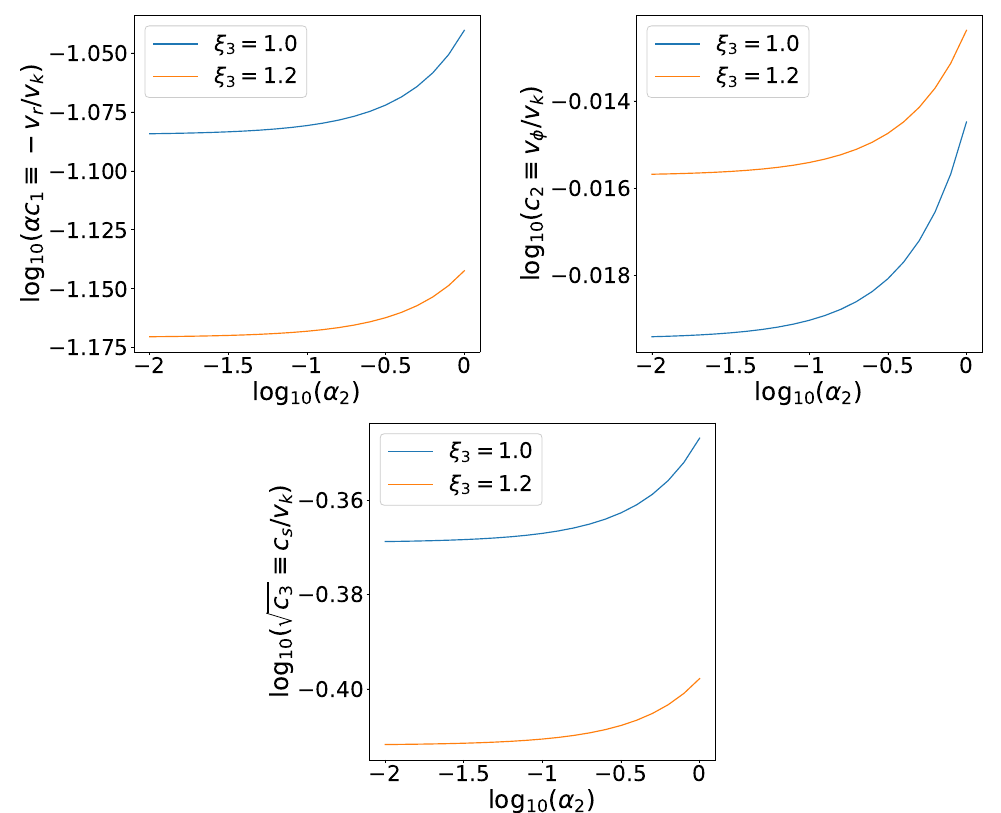
Figure 3. The properties of the accretion flow when outflow is present ( s = 1/2). The top-left panel plots radial infall velocity (in units of Keplerian velocity) as a function of the strength of anisotropic pressure ( α 2 ). The top-right panel plots rotational velocity (in units of Keplerian velocity) as a function of the strength of anisotropic pressure ( α 2 ). The lower panel plots sound speed (in units of Keplerian velocity) as a function of the strength of anisotropic pressure ( α 2 ). The viscous coefficient α 1 was set to be 0.1. The ratio of magnetic to gas pressure β was set to be 0.1. ξ 1 is the ratio of outflow radial velocity to inflow radial velocity. ξ 2 is the ratio of outflow rotational velocity to inflow rotational velocity. ξ 3 is the ratio of outflow sound speed to inflow sound speed. We set ξ 1 = ξ 2 = 1. The blue and yellow lines correspond to ξ 3 = 1 and ξ 3 = 1.2,